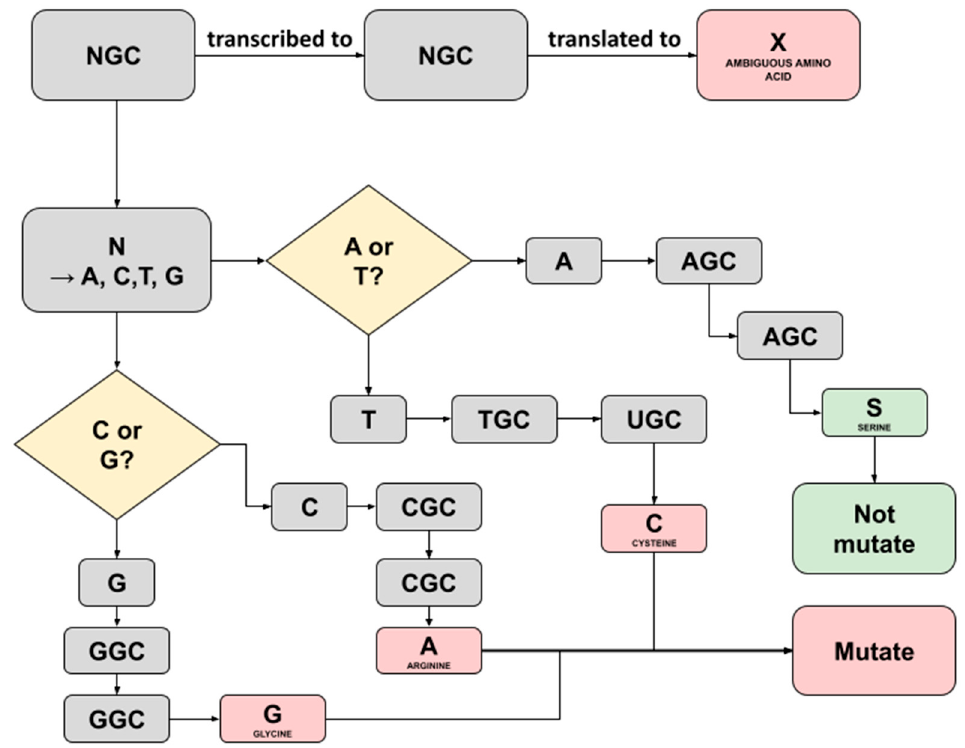
Figure 5. Illustration depicting the possible translation result of ambiguous amino acid X detected in Sample F2 running in Normal Pipeline. An X amino acid was detected at position 769 region NSP12-ORF1AB.